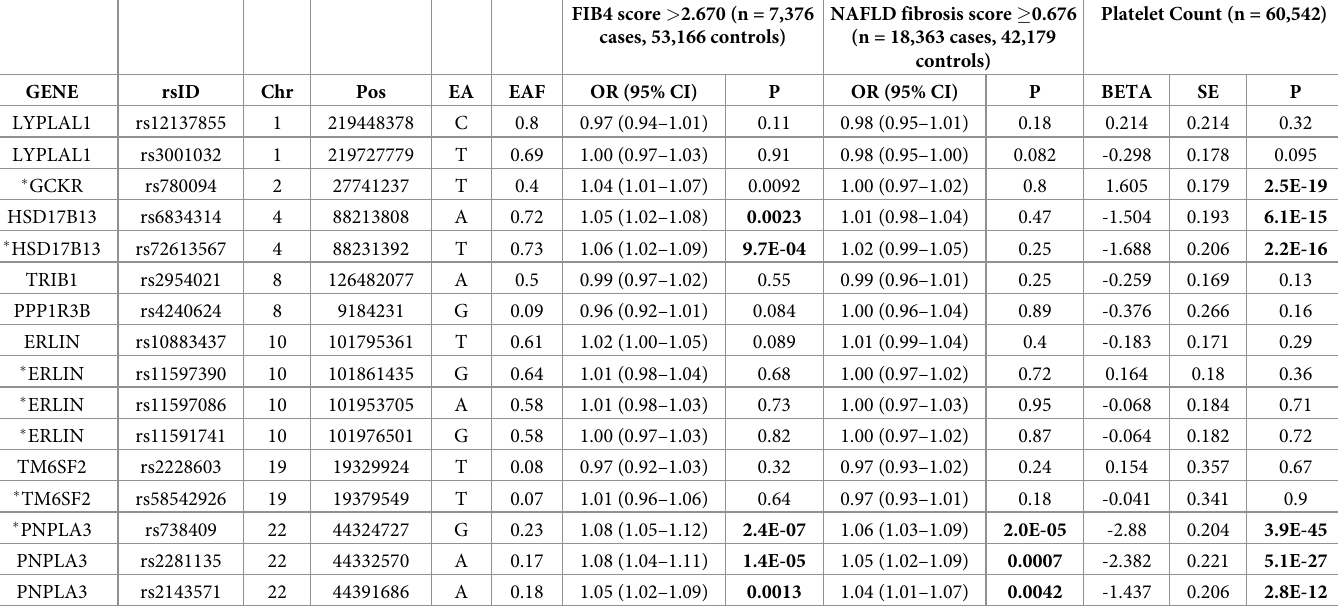
Table 5. Previously published ALT level/NAFLD risk-associated variants with genome-wide significance and associations with advanced fibrosis/cirrhosis and platelet count at enrollment among patients with NAFLD (n =